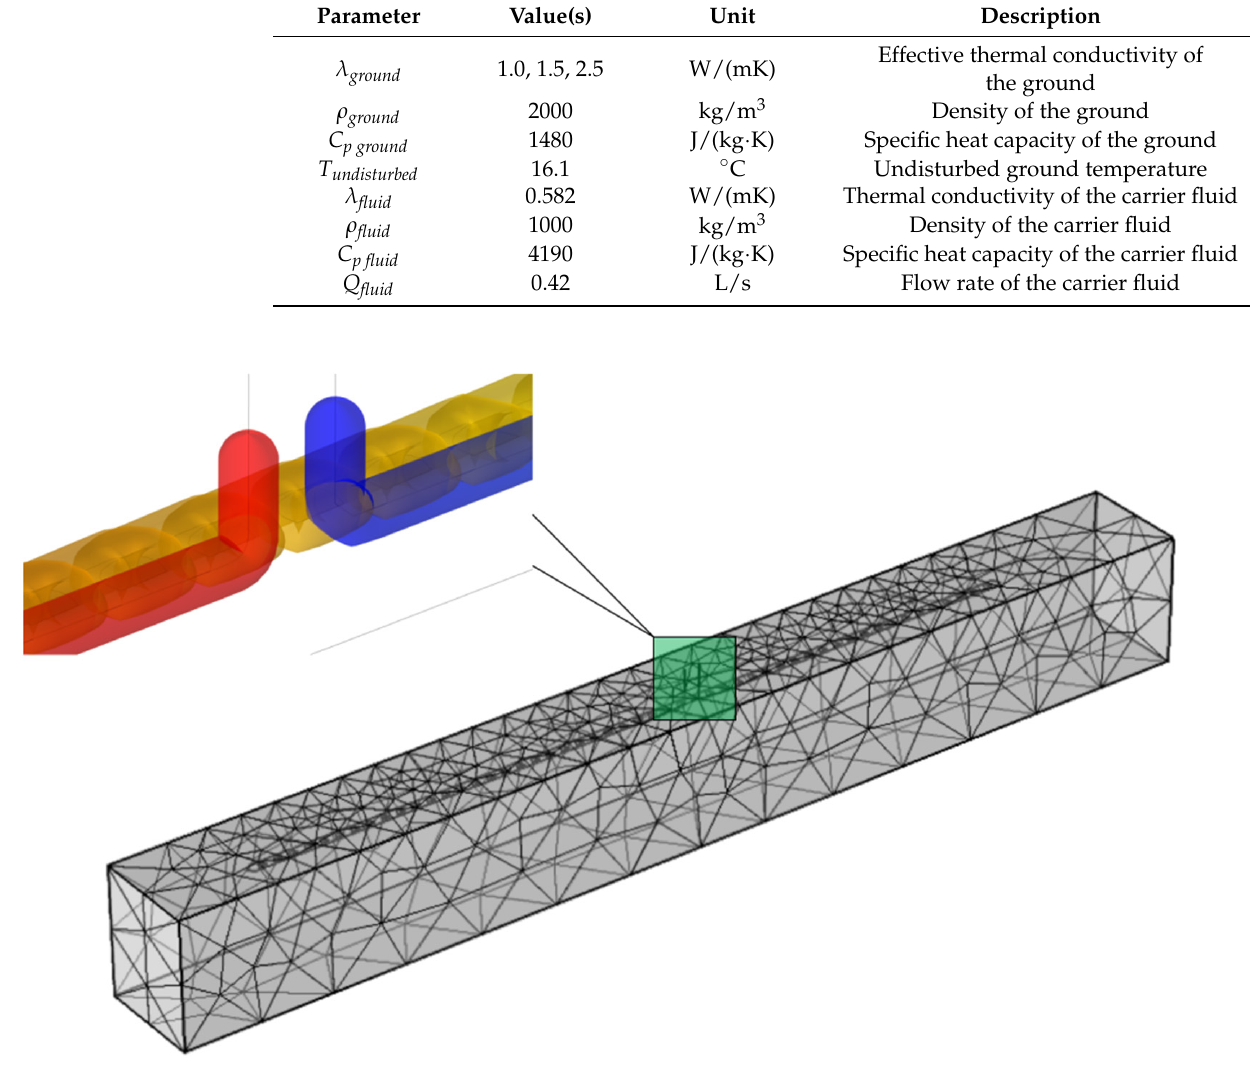
Figure 4. Detailed configuration of the inlet and outlet pipes.